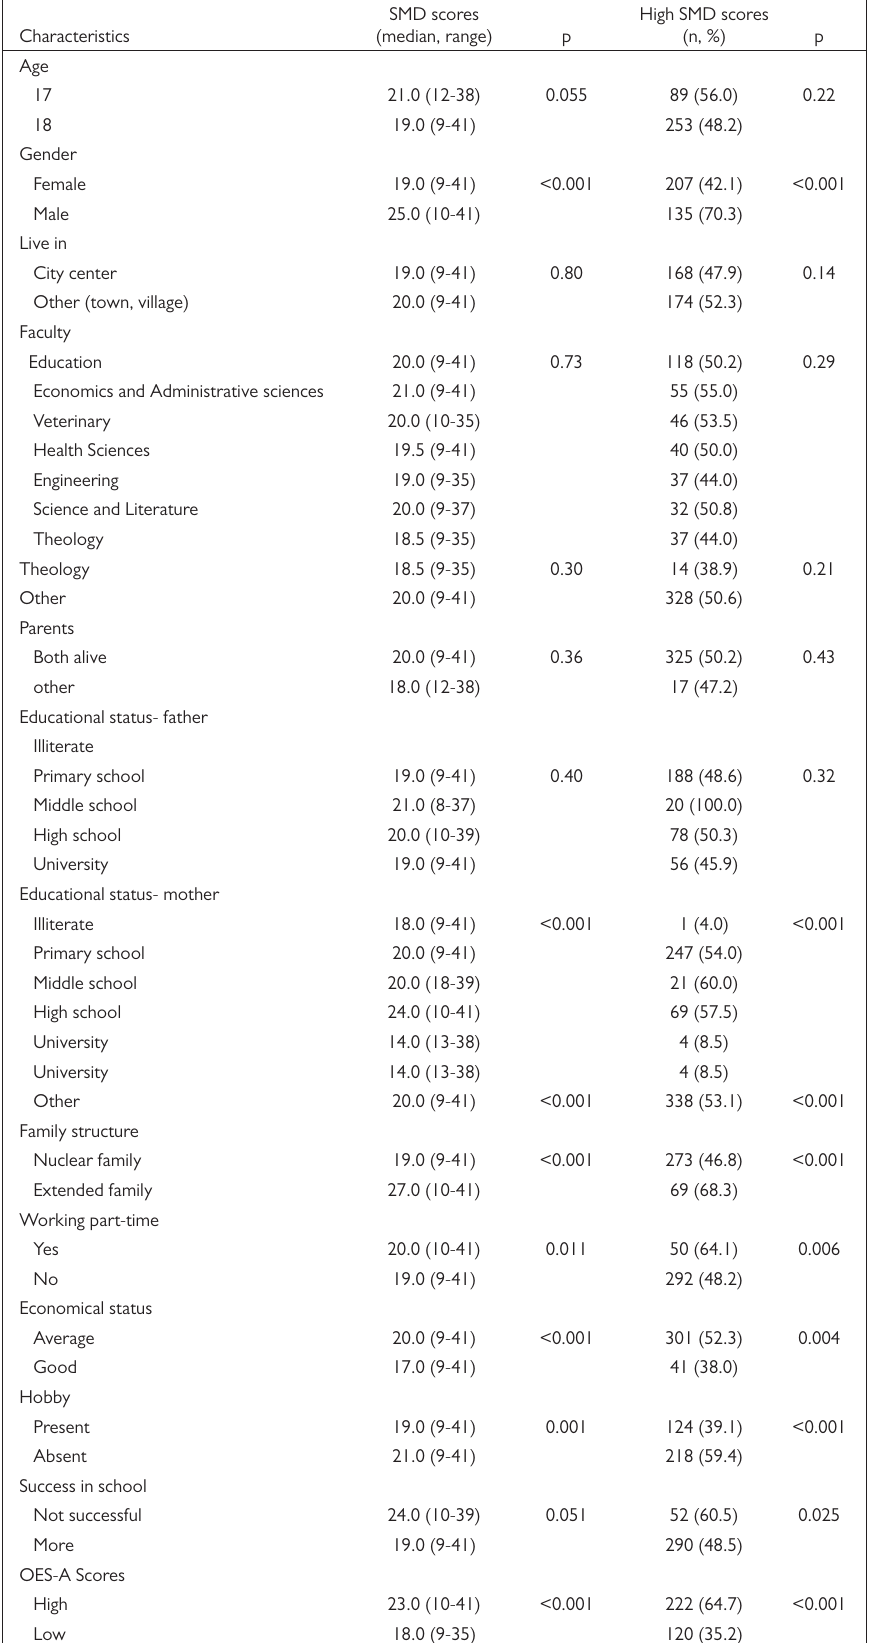
Table 2. The factors associated with SMD scores